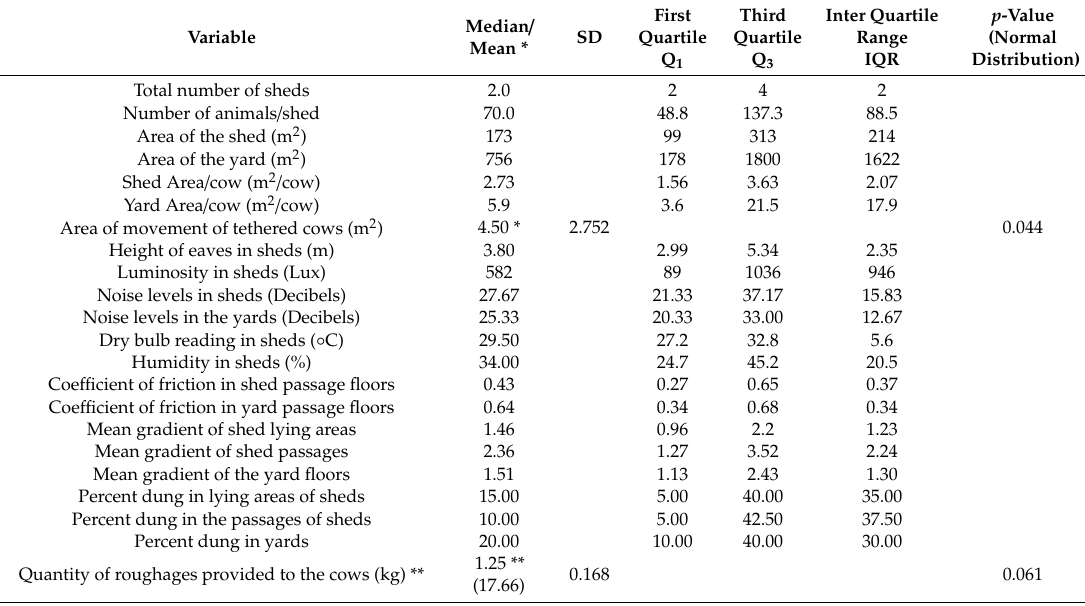
p -Value Third Inter Quartile First Median / (Normal Quartile Range SD Quartile Mean * Distribution) Q 1 Q 3 IQR